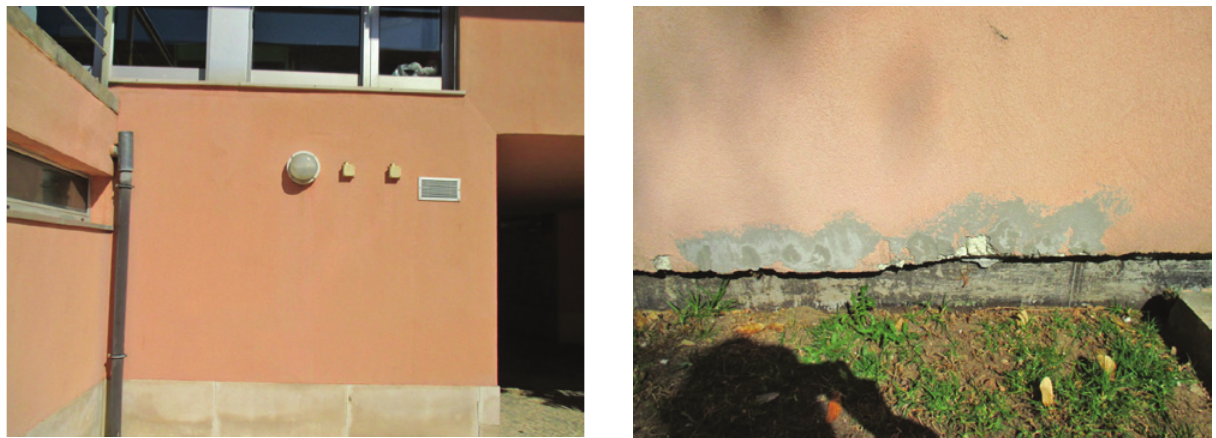
Figure 5. Comparison between two façades with ETICS: one with good execution (left) and the other with execution mistakes